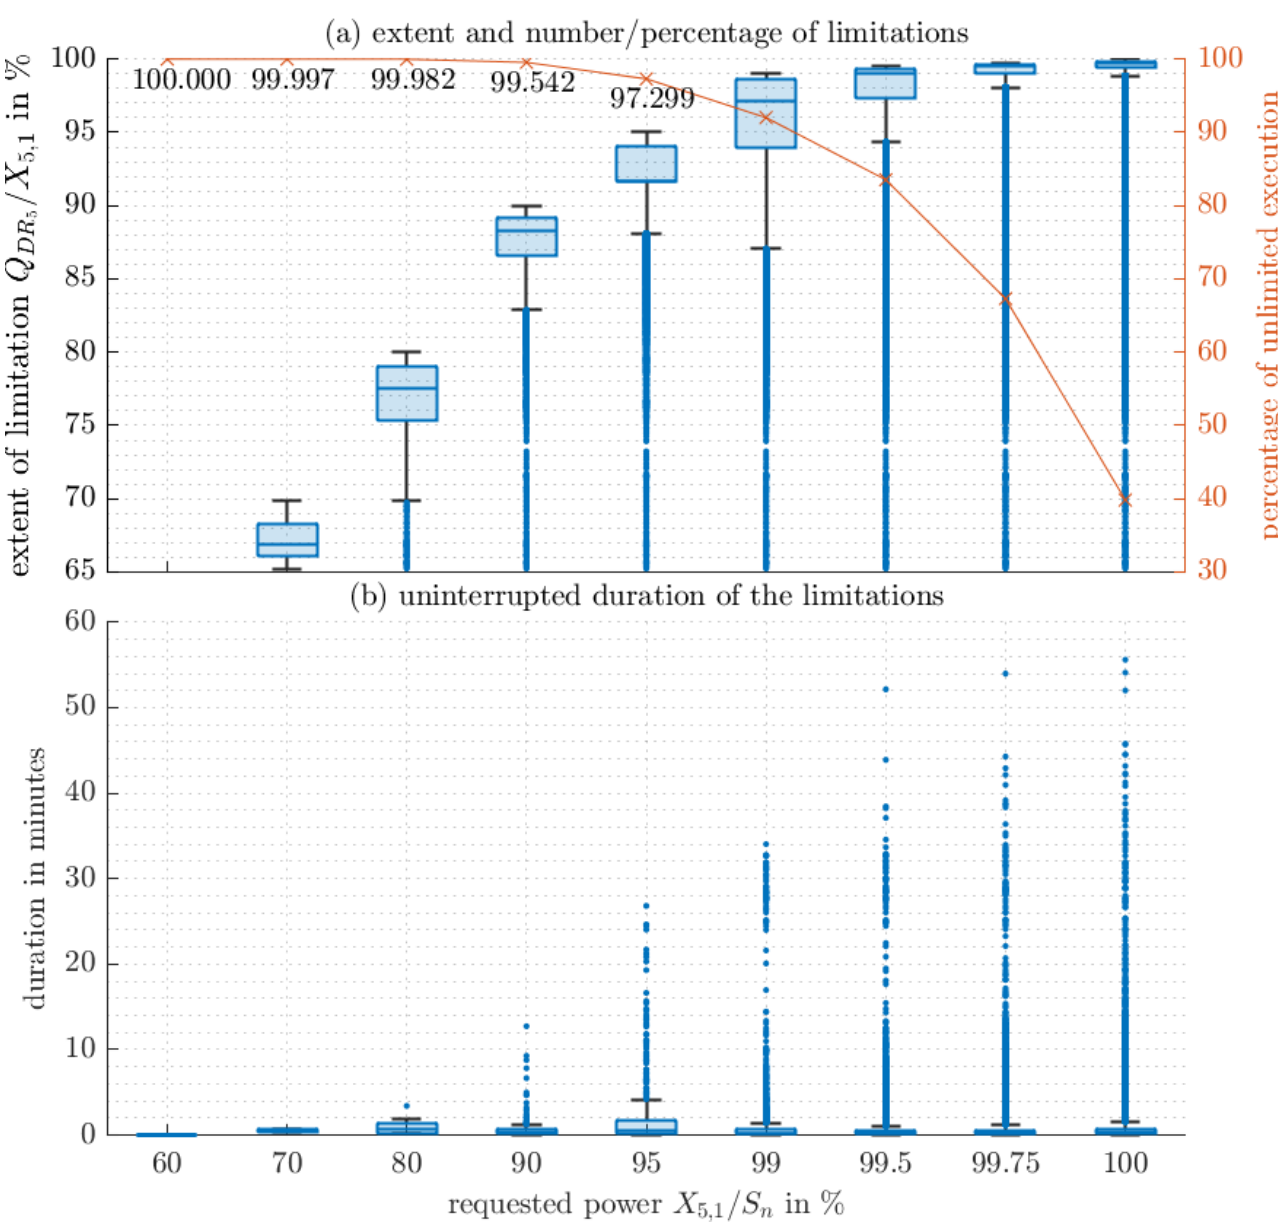
Figure 10. Simulation results of the limitation of the function F 5 static voltage support during long-time simulation in M ATLAB /S IMULINK